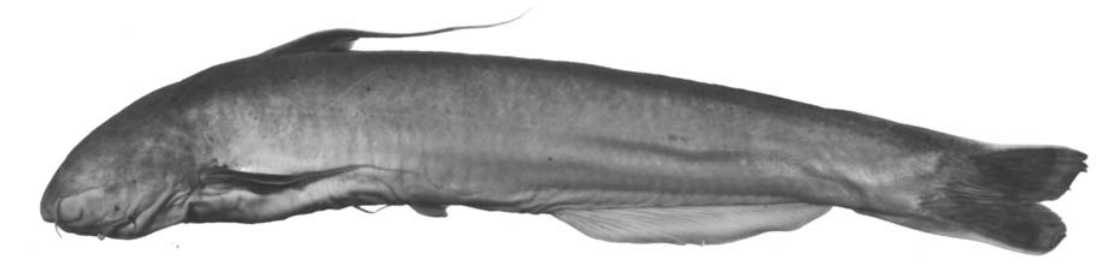
Fig. 17. Cetopsis candiru , mature male, FMNH 112635, 194 mm SL; Peru, Loreto, río Pastaza basin, caño tributary to laguna Rimachi, near río Rimachi, at Rimachi (4°26.91’S,